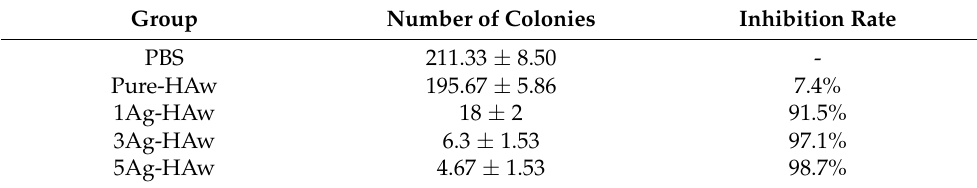
Figure 5. Representative photos of E. coli and S. aureus on PBS, Pure HAw and (1, 3, 5) Ag-HAw, ZnO/(1, 3, 5) Ag-HAw. ( a – e ) The antibacterial result of Ag-HAw on E. coli ; ( f – j ) the antibacterial result of Ag-HAw on S. aureus ; ( k – o ) the antibacterial result of ZnO/Ag-HAw on E. coli ; ( p – t ) the antibacterial result of ZnO/Ag-HAw on S. aureus . Table 5. Number of E. coli plate colonies and antibacterial rates in different samples.